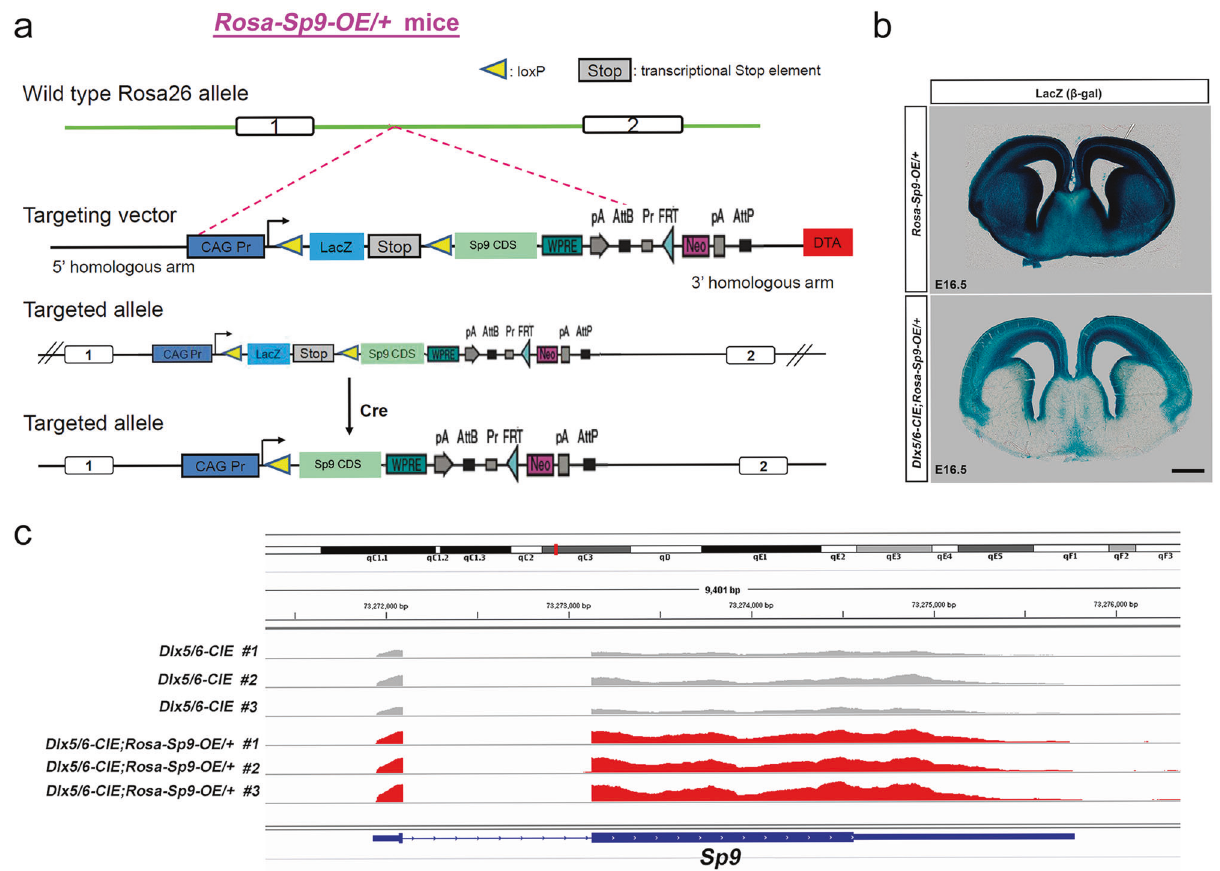
Fig. 5 Generation of Rosa-Sp9-OE/ + mice. a The construction strategy of generating mice with conditional Sp9 overexpression (OE). b β -gal staining of Dlx5/6-CIE and Dlx5/6-CIE; Rosa-Sp9-OE/ + brains at E16.5. c Bulk RNA-sequencing revealed higher Sp9 expression levels (reads) in the Dlx5/6-CIE; Rosa-Sp9-OE/ + LGE than in the control at E16.5. Scale bar: b , 500